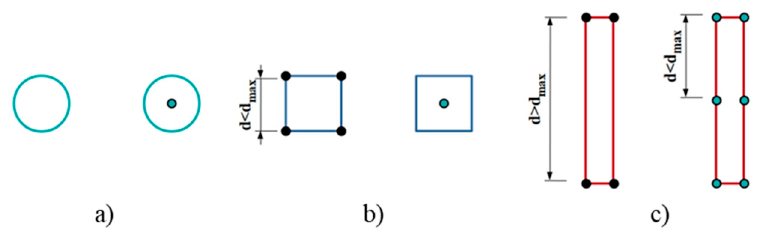
Figure 6. Generation of seed points S e (in blue) for triangulation process for: ( a ) column, ( b ) polygon with side < d min and ( c ) polygon with side < d min .